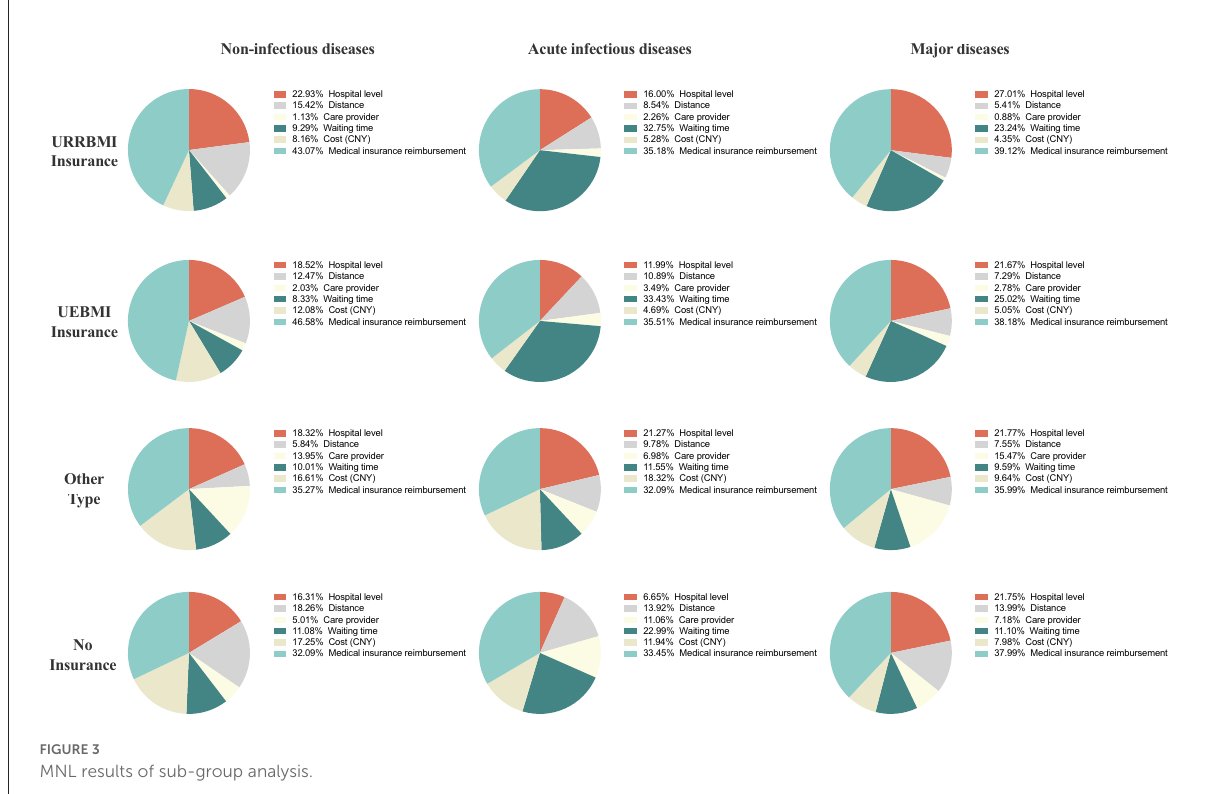
FIGURE3 MNL results of sub-group